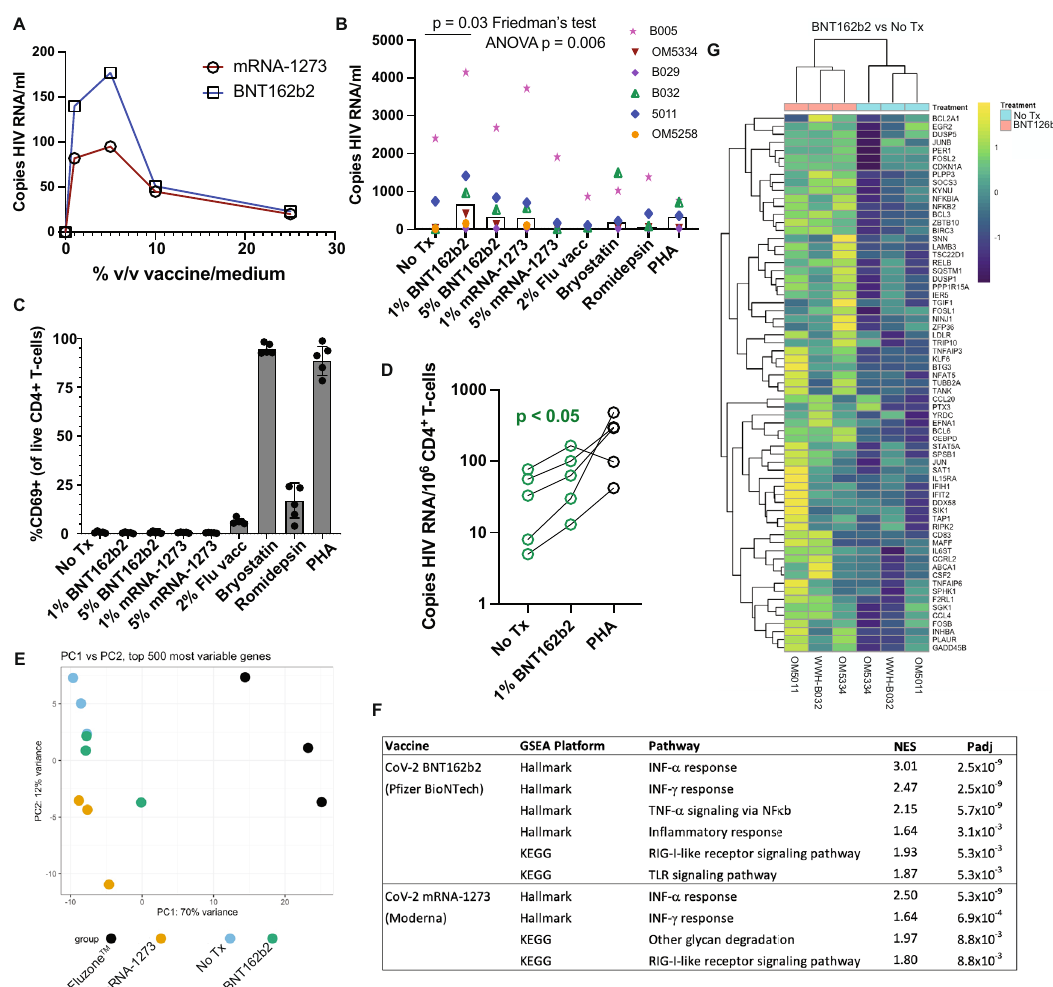
Fig. 1 | The BNT162b2 mRNA vaccine stimulates the RIG-I/TLR – TNF- α – NF κ b axis and activates HIV transcription ex vivo. A qPCR measurements of HIV RNA in supernatants, 48hours following ex vivo treatment of PBMCs from an ART- treated participant with the indicated concentrations of BNT126b2 (P fi zer BioN- Tech) or mRNA-1273 (Moderna) mRNA vaccines. B Extension of results from A to n =6 ART-treated participants, adding treatments with 2% volume/volume Flu- zone ™ in fl uenza vaccine, 25nM bryostatin-1, 40nM romidepsin, or 2 μ g/ml phytohemagglutinin-L (PHA). P values were calculated by Friedman test with Dunn ’ smultiplecomparisontest(two-tailed). C Flowcytometrydatafromthesame samples n =5 donors harvested for ( B ) Shown are % CD69 + (activated) following gating on viable CD4 + T-cells. Data are presented as mean values +/ − SD. D Cell- associated HIV RNA measures from the same samples as ( B ) P value of 0.0487 was